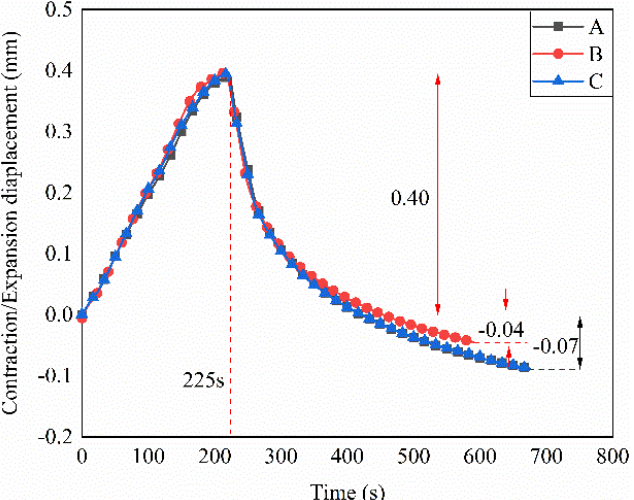
Figure 10. Displacement-time curves of welding specimens obtained with different types of heating elements at the powder densities listed in Table